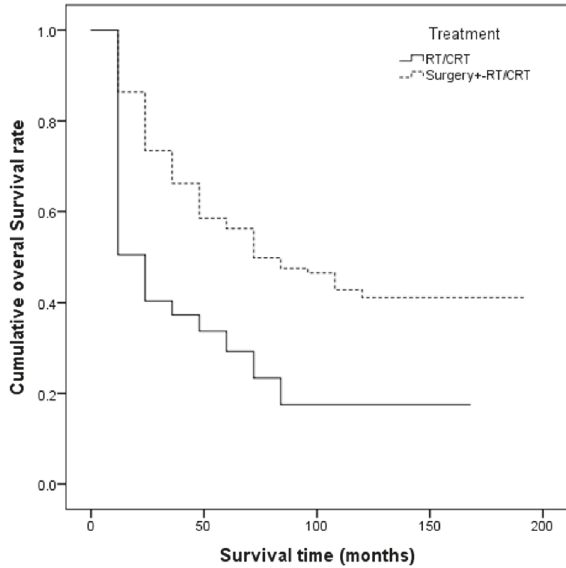
Figure 2: Survival rate according to treatment strategy among pa- tients diagnosed with laryngeal cancer, South of Iran, 2000–2015 ( 𝑃 value < 0.001).